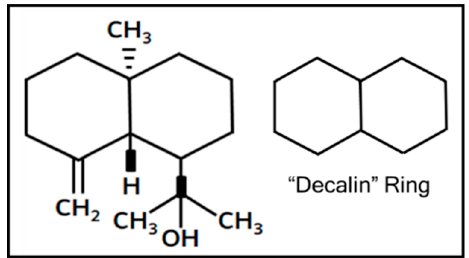
Figure 9. Structure of IM60 with the decalin ring highlighted on the side.